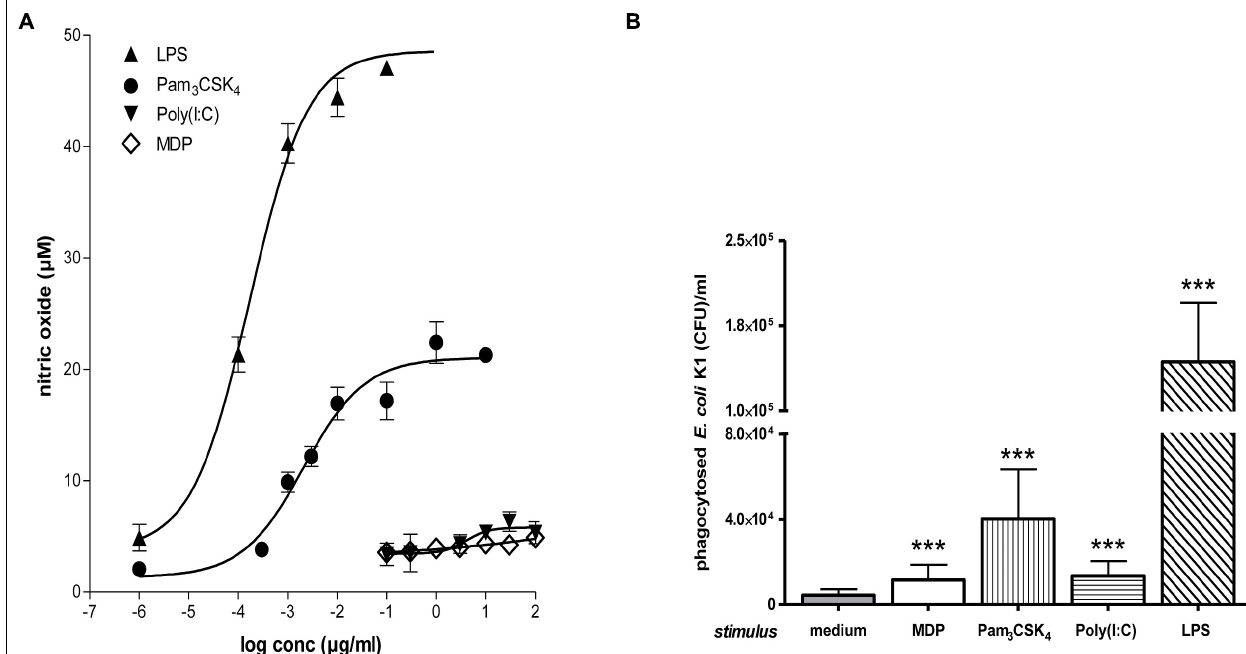
FIGURE 5 | Microglial NO release and phagocytosis of bacteria. (A) Stimulation with TLR2 or 4 agonists induced stronger microglial nitric oxide (NO) release than stimulation with a TLR3 agonist or muramyl dipeptide (MDP). Dose–response relations after 24 h treatment with various concentrations of agonists of TLR1/2 (Pam 3 CSK 4 ), TLR3 [poly(I:C)], TLR4 (LPS), and NOD2 (MDP; Ebert etal., 2005; Ribes etal., 2009; Ribes etal., 2012). (B) Phagocytosis of E. coli K1 strain by microglial cells after 24 h of stimulation with the agonists at the lowest